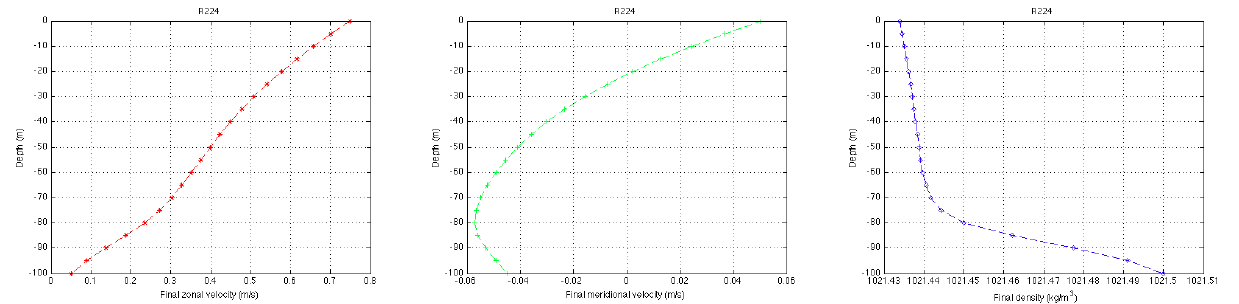
Fig. 10. Test 2: mixing-layer zonal velocity, meridional velocity and density profiles (from left to right) for model R